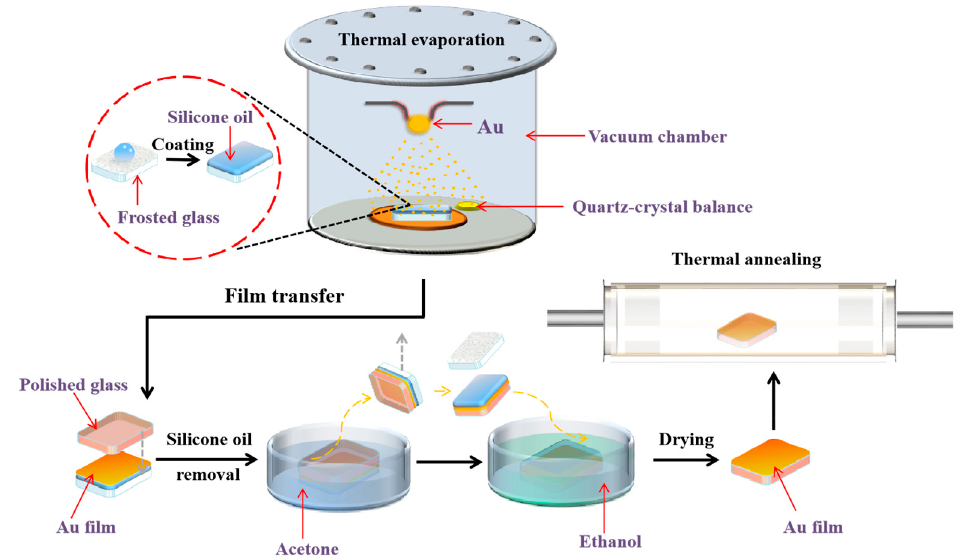
Figure 7. Schematic diagram of depositing Au atoms on silicone oil surfaces by thermal evaporation.